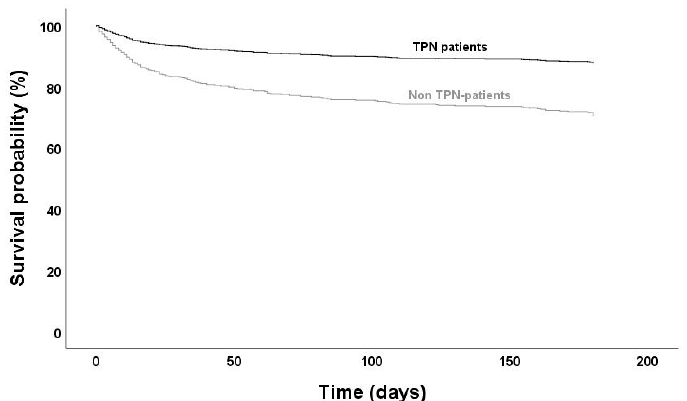
Figure 3. Kaplan–Meier curves for survival time in patients with S. aureus bacteremia. TPN: total parenteral nutrition. Log-rank test: p = 0.001.